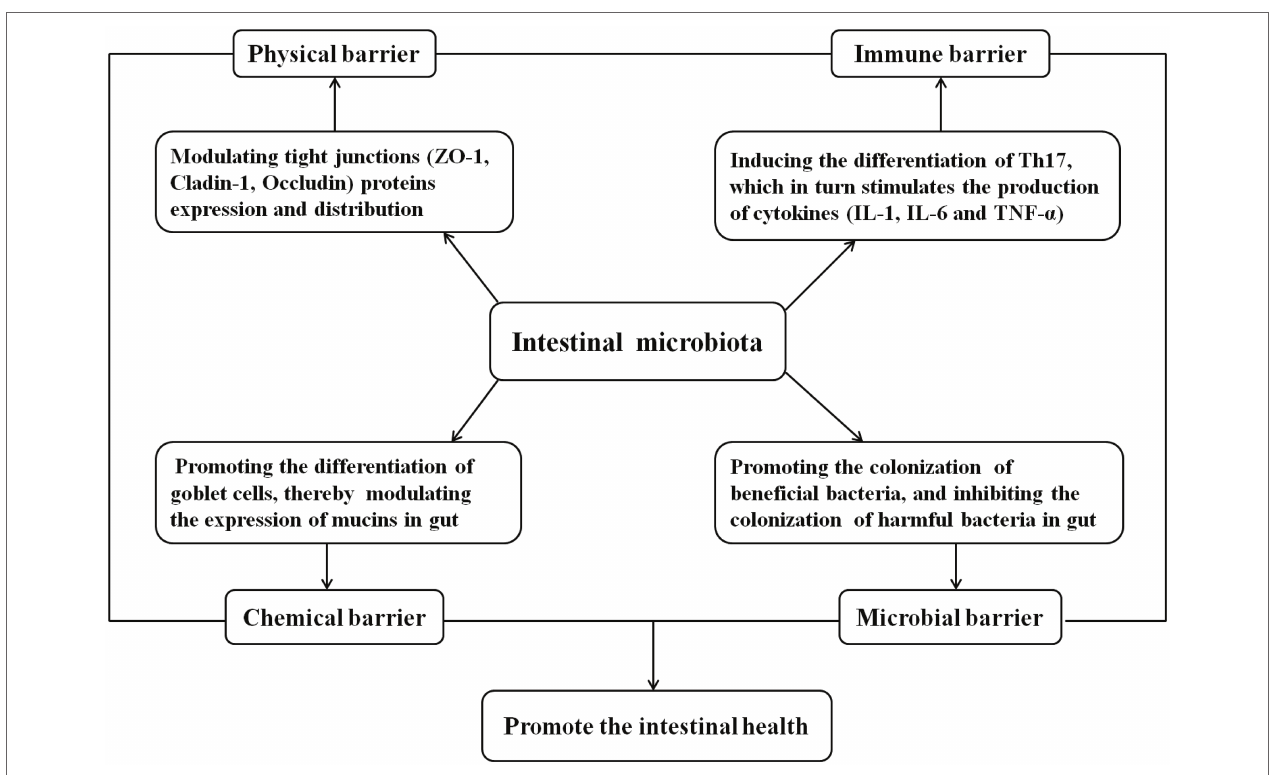
FIGURE 2 | Relationship between gut microbiota and intestinal